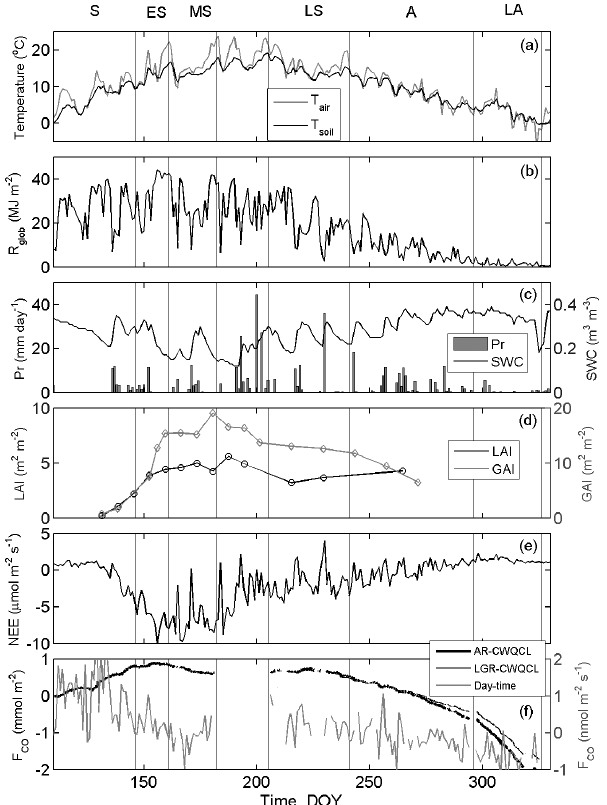
Figure 1. (a) Daily mean air and soil temperatures, (b) global ra- diation sum ( R glob ) , (c) daily precipitation sum ( P r ) and soil water content (SWC), (d) weekly leaf area index (LAI; black) and green area index (GAI; grey), (e) net ecosystem exchange of CO 2 (NEE), and (f) cumulative CO fluxes calculated from half-hour mean CO fluxes (cumulative F CO ; black lines) and daytime mean CO fluxes ( F CO_day ; grey) over the 7-month measurement period in a reed canary grass crop. Measurement periods (S is spring, ES is early summer, MS is midsummer, LS is late summer, A is autumn, LA is late autumn) are separated by solid lines.